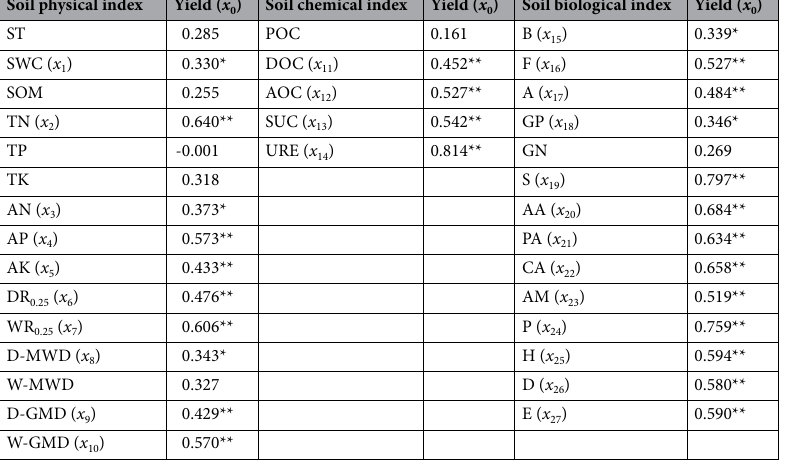
Table 2. Correlation coefficients of soil environment factors and rapeseed yield. *Significant at the 0.05 probability level. **Significant at the 0.01 probability level.